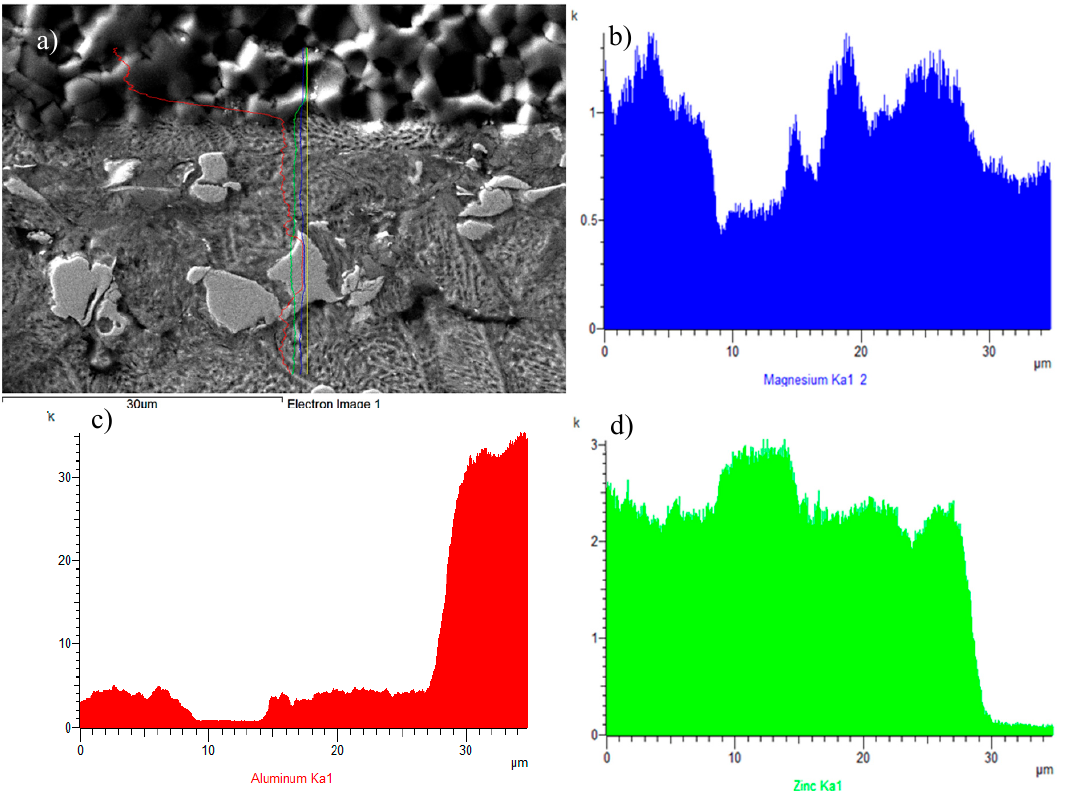
Figure 16. Concentration profiles of elements in the boundary of the AlN / Zn–Al–Mg joint, ( a ) joint microstructure, ( b ) Mg profile, ( c ) Al profile, ( d ) Zn profile.